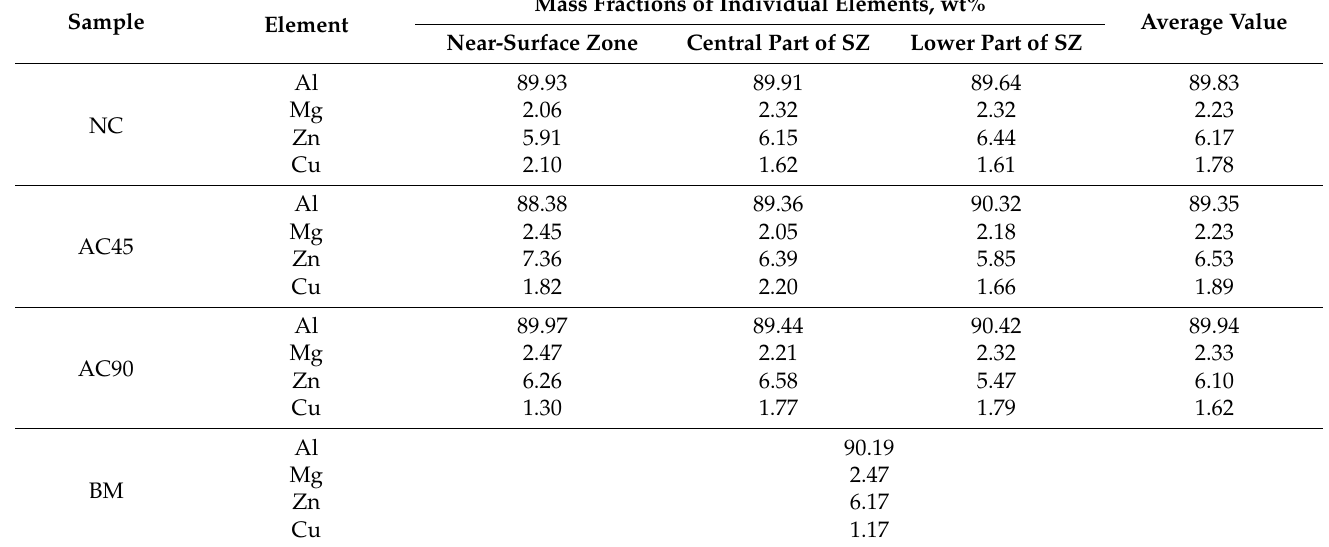
Table 5. EDS analysis